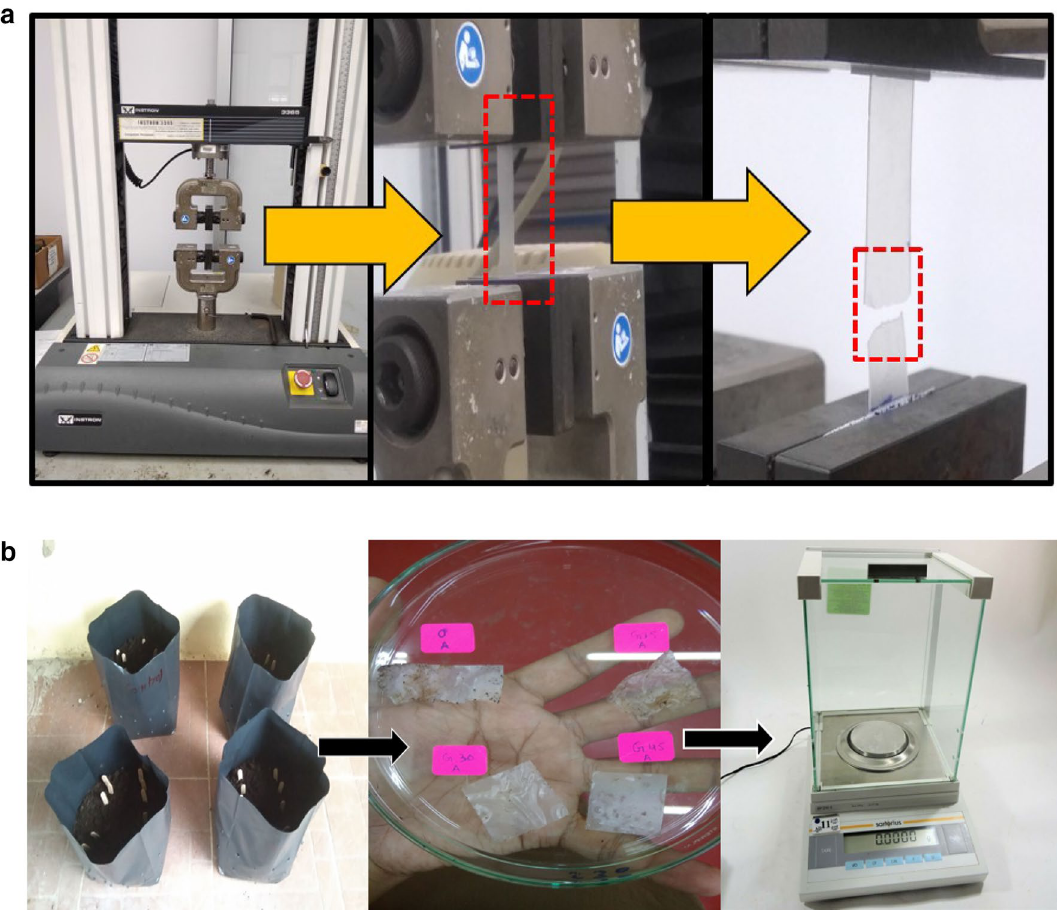
Figure 2. ( a ) Mechanical testing of arrowroot starch-based film samples. ( b ) Setup of the soil burial